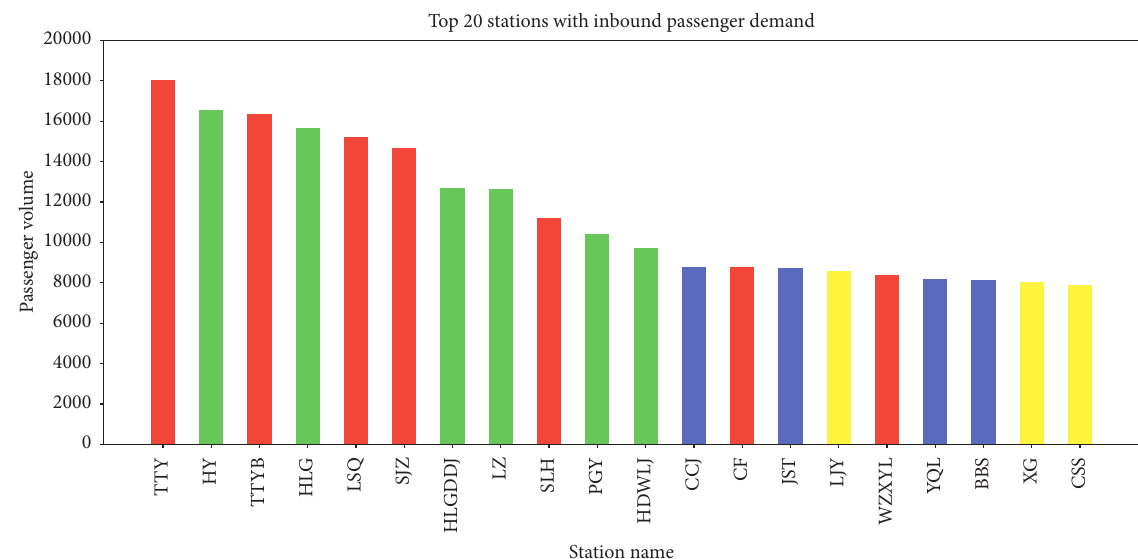
Figure 13: The lines connected with Line9.